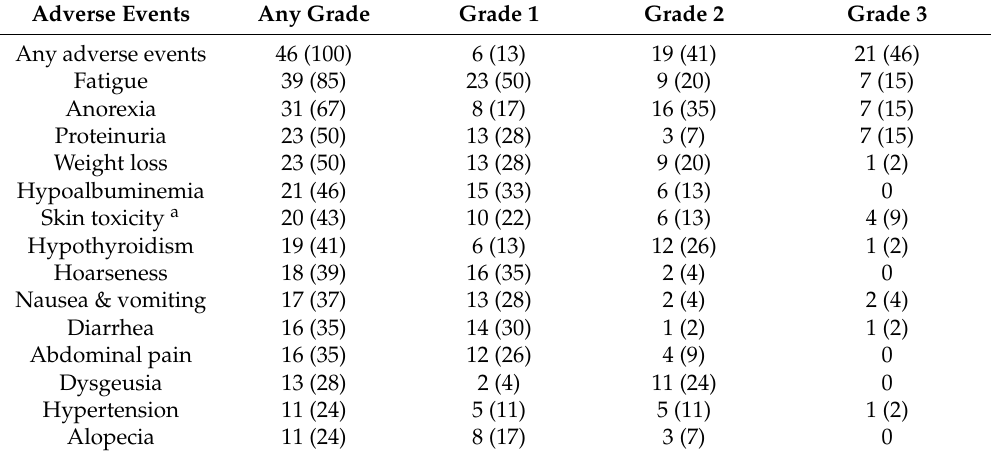
Table 2. Adverse events ( n = 46).